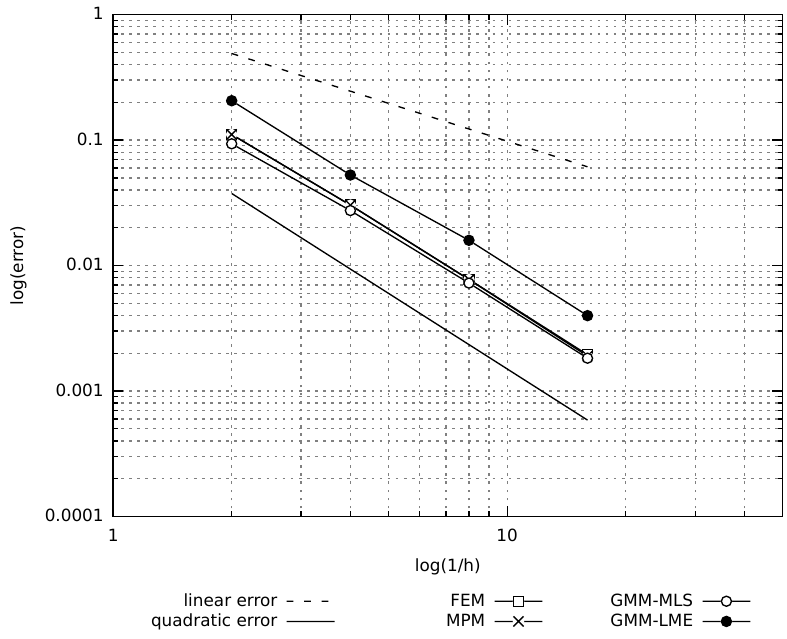
Figure 7. Static cantilever. Convergence analysis.